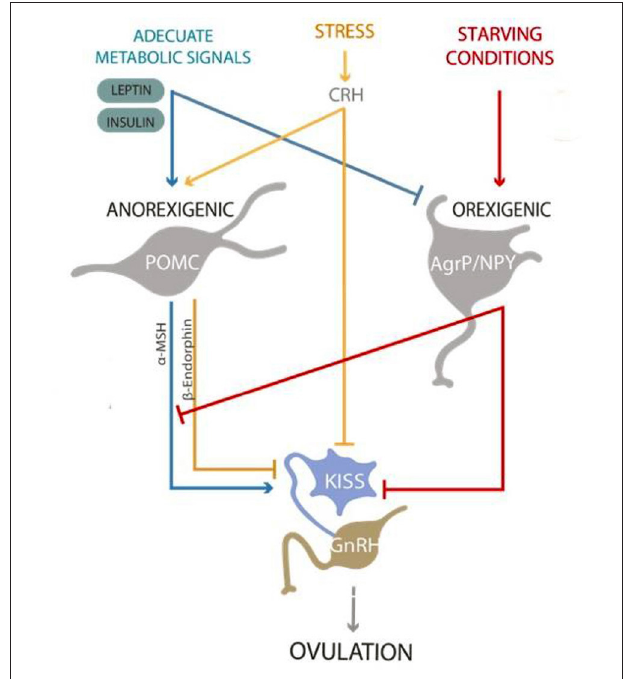
FIGURE 2 | Kisspeptinergic neurons from the “preoptic area” and “arcuate nucleus” release kisspeptin to stimulate GnRH neurons to release GnRH. Under proper nutritional conditions, the presence of metabolic signals such as insulin and leptin will activate anorexigenic neurons, as the POMC neurons that release α -MSH, causing satiety. On the other hand, insulin and leptin will inhibit the orexigenic neurons, which release NPY and AgRP, causing hunger. Proper metabolic signals will stimulate the release of kisspeptin and promote ovulation. On the contrary, signs of starvation and/or stress will inhibit the release of kisspeptin, affecting ovulation and the reproductive process.